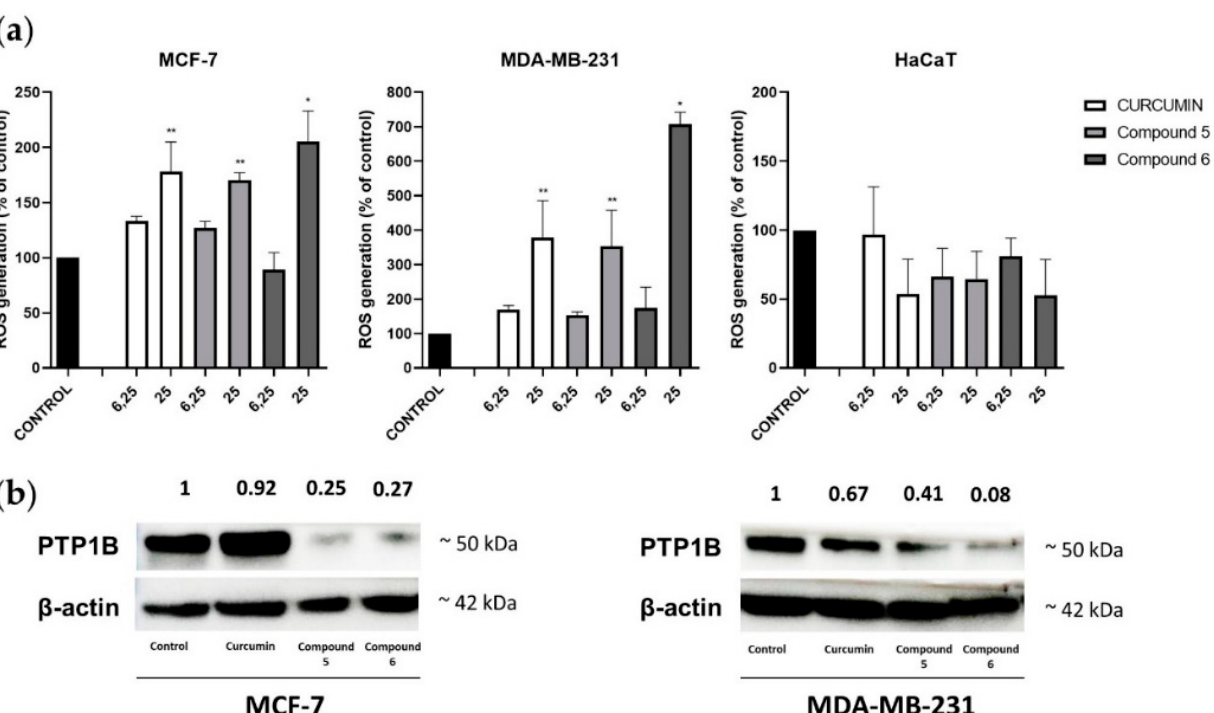
Figure 4. ( a ) The levels of ROS induced by curcumin, compound 5 , and compound 6 in concentrations of 6.25 and 25 µ M in MCF-7, MDA-MB-231, and HaCaT cell lines after 24 h of incubation. The results were presented as a percentage of control (mean ± SD, n = 3, * p < 0.0001; ** p < 0.01); ( b ) Western blot of PTP1B expression in cancer cells.